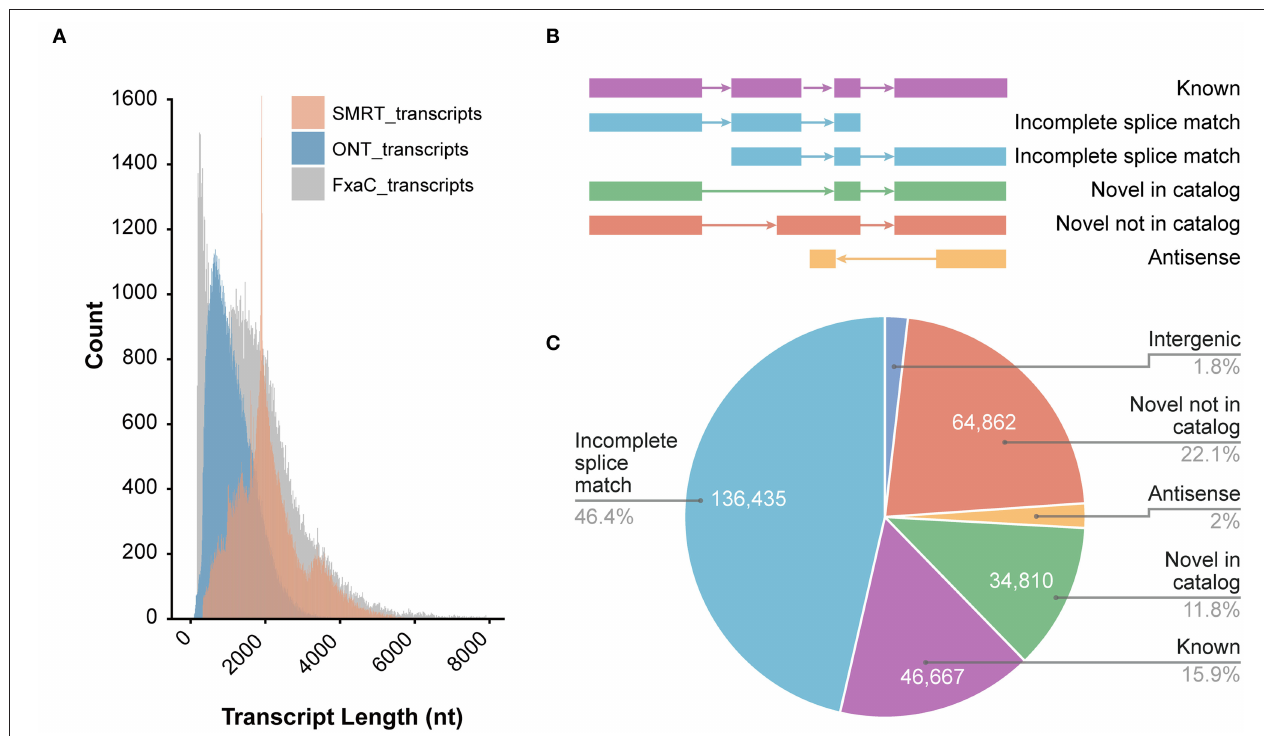
FIGURE 1 | Overview of the ONT sequencing data. (A) The length distribution of ONT transcripts in comparison with SMRT and those known transcripts in the genome annotation. SMRT_transcripts were from the non-redundant transcripts in the PacBio sequencing project of the previous study (SRA record PRJNA510532) using the same cultivar. FxaC_transcripts were extracted from the latest genome annotation (v1.0a2) profile. (B) The known or novelty definition diagram according to the category of TALON pipeline. (C) Counts of the transcripts and the proportion of each